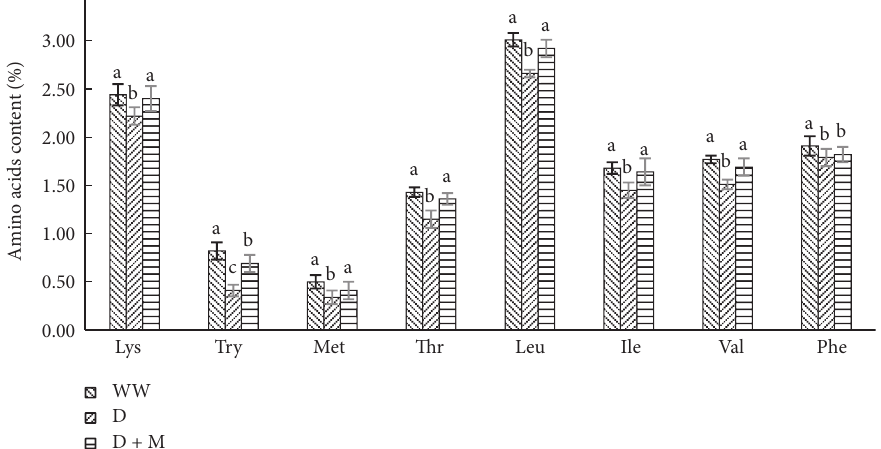
Figure 3: Effect of exogenous melatonin on amino acid content in soybean under drought stress. Data are represented as average ± SD ( n � 3). Different letters indicate significant differences ( p < 0 . 05). Table 3: Effect of exogenous melatonin on the isoflavone content in soybean under drought stress.